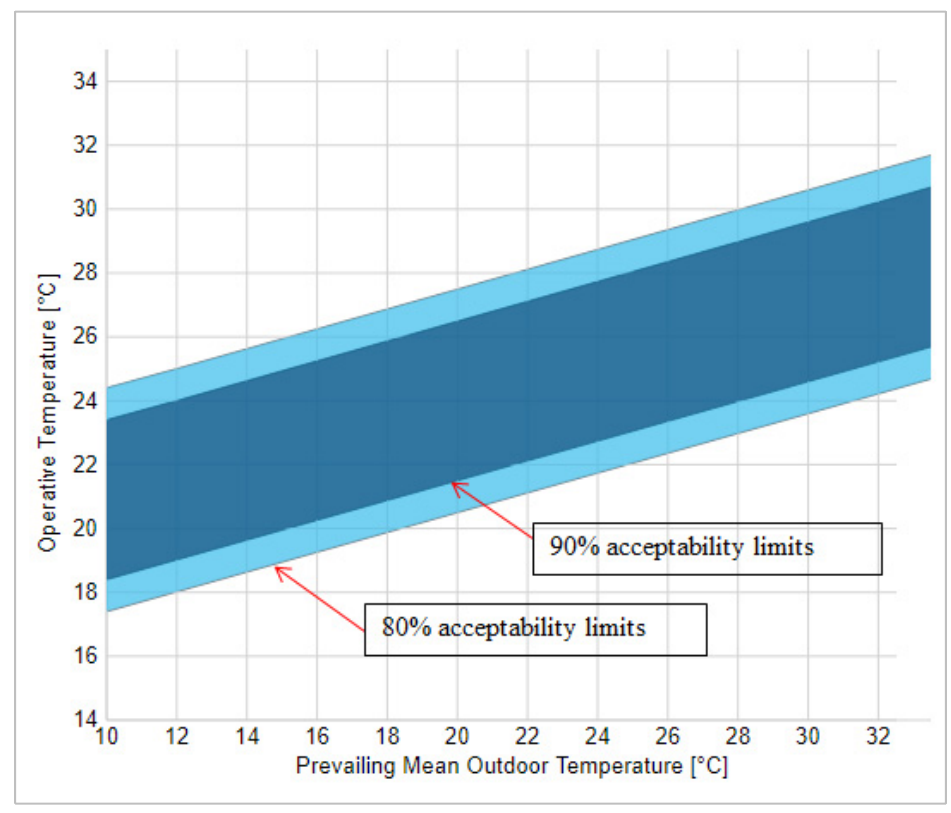
Figure 1. Adaptive comfort models represented in ANSI/130 ASHRAE 55:2017.